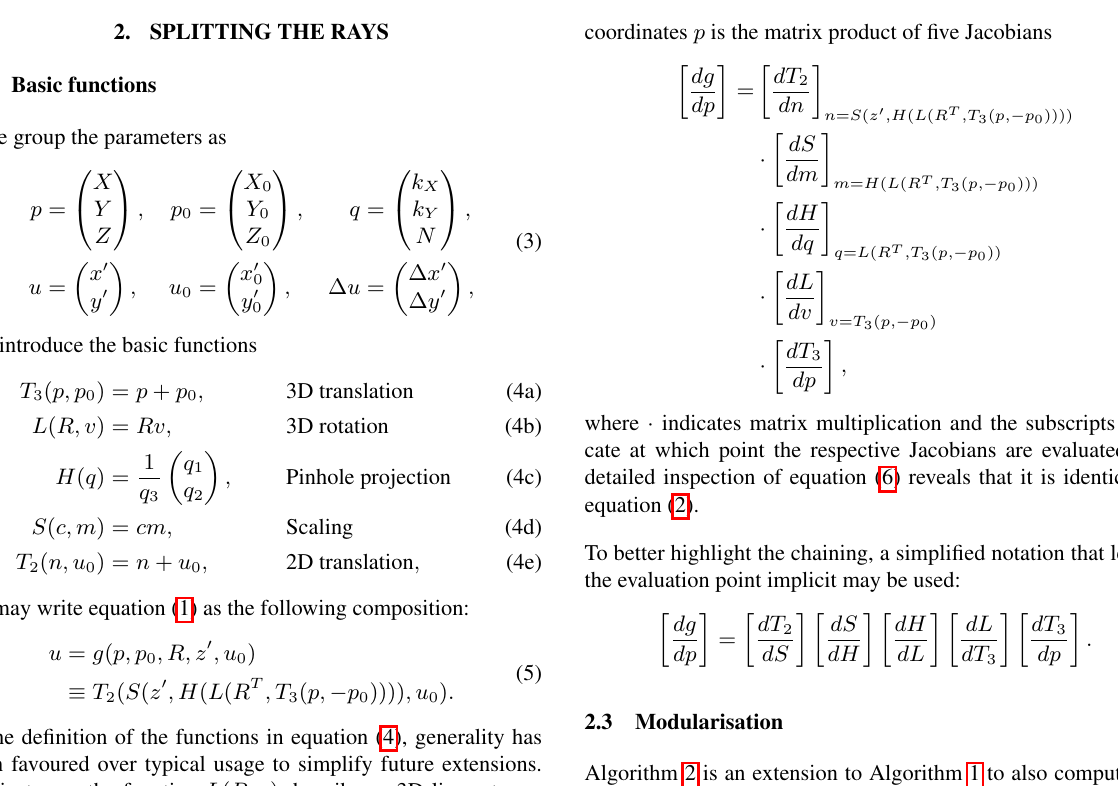
Figure 1: The computational chain corresponding to equation (5). The gray circles indicate bundle adjustment parameters. The white circles indicate component functions in equation (4). The arrows indicate how the parameters and results are propagated. The arrow labels indicate the name of the formal (input) parameter of the corresponding